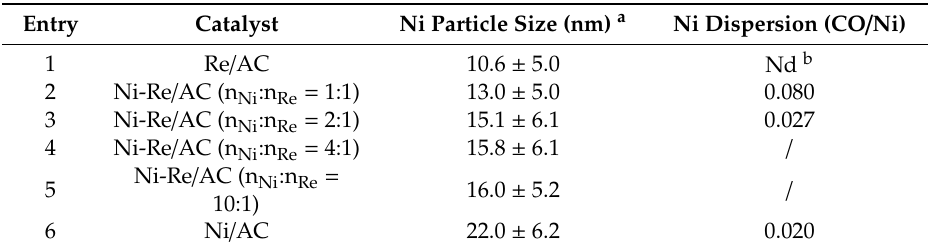
Table 1. Sizes and XPS results of various